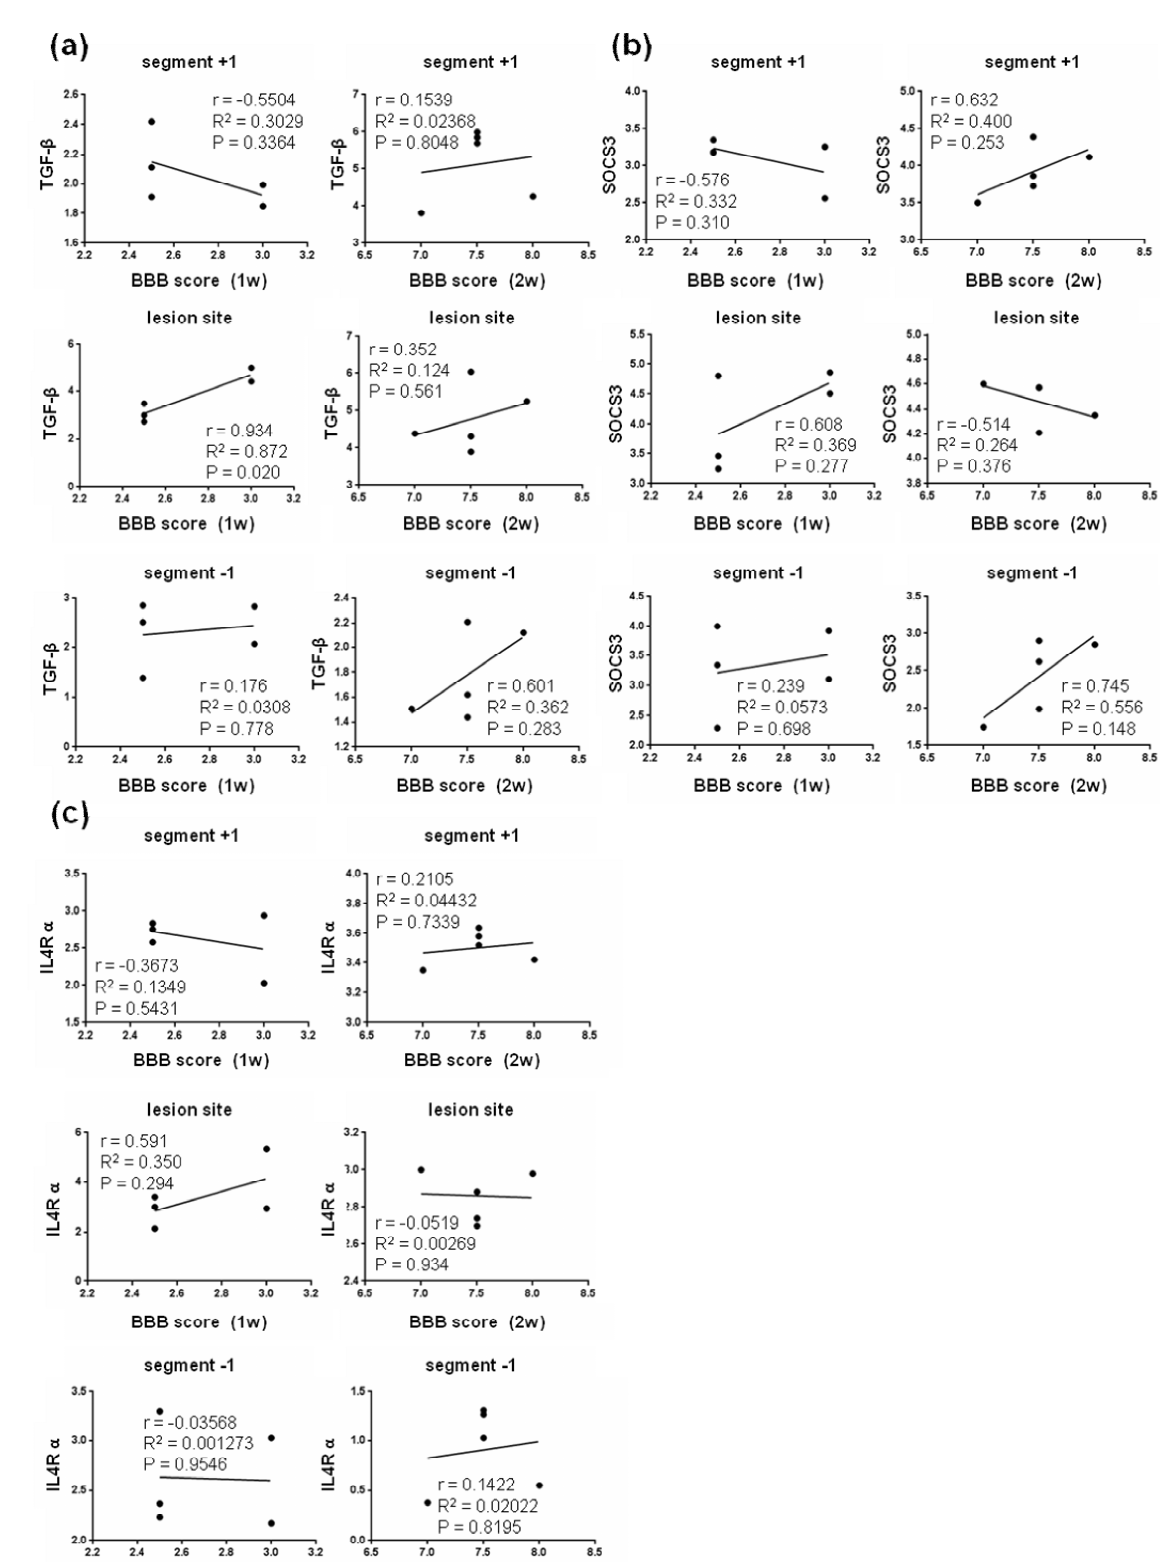
Figure 9. Linear regression analysis of correlation between BBB score and relative gene expression of markers characteristic for protective microglial M2c phenotypes—TGF- β ( a ), SOCS3 ( b ), and IL4R α ( c ) at injury site and in adjacent cranial and/or caudal segments one and two weeks post-SCI. Scatterplots of individual values ( n = 5) with regression line correlation coefficient (r), coefficients of determination (r2) calculated using regression analysis and p -value. SCI—spinal cord injury; TGF- β —transforming growth factor beta; SOCS3—suppressor of cytokine signaling 3; IL4R α —interleukin 4 receptor alpha.